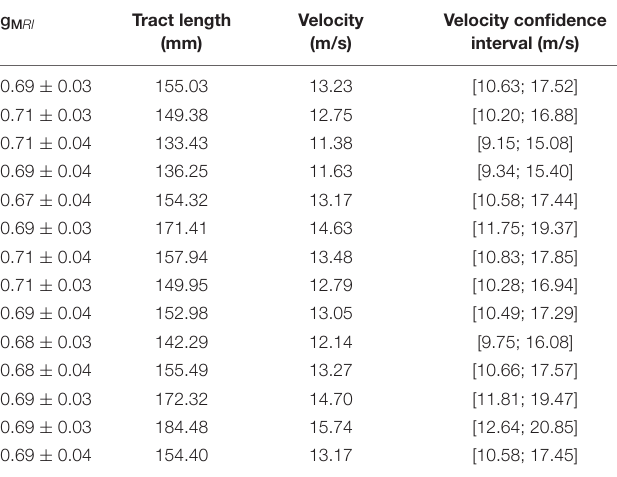
TABLE 1 | MRI-measured g-ratios, measured tract length, and estimated conduction velocity with corresponding confidence interval, for each subject in the visual transcallosal